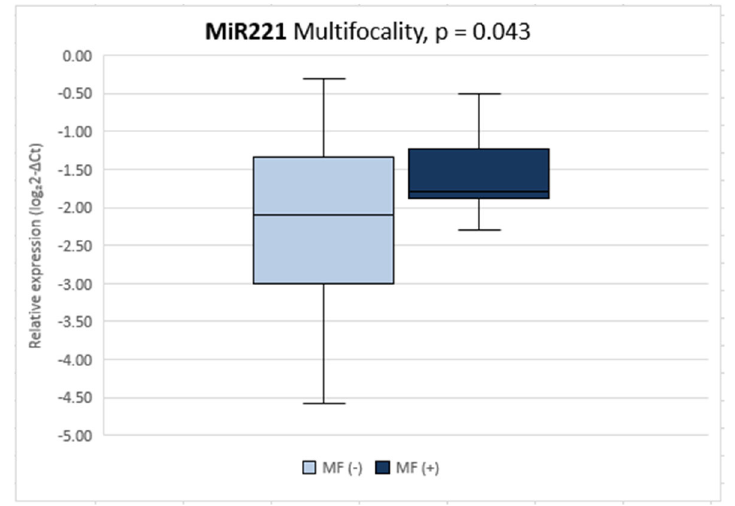
Figure 1. Comparison of miR221 relative expression between solitary and multifocal PTC. The box squares represent the data within 25 and 75 percentiles, the line in the middle shows the median; p < 0.05. MF: multifocality.